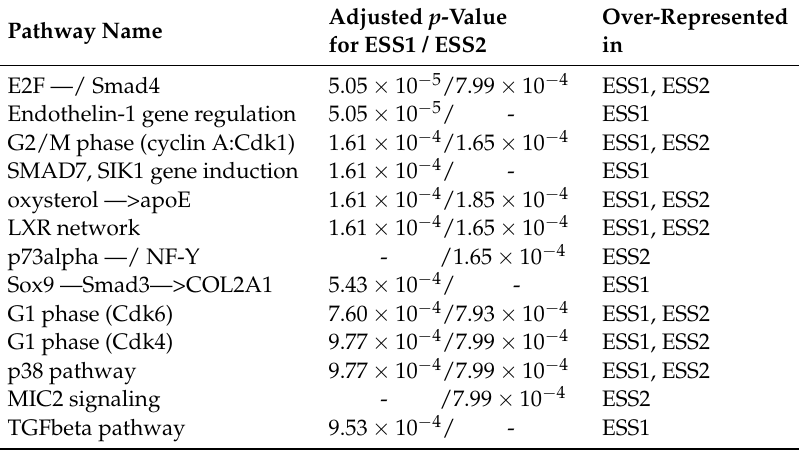
Table 3. Significantly over-represented pathways for both time points ( p adjusted < 0.001) sorted by adjusted p -values (based on the smaller one of either ESS1 or ESS2). Pathways are based on